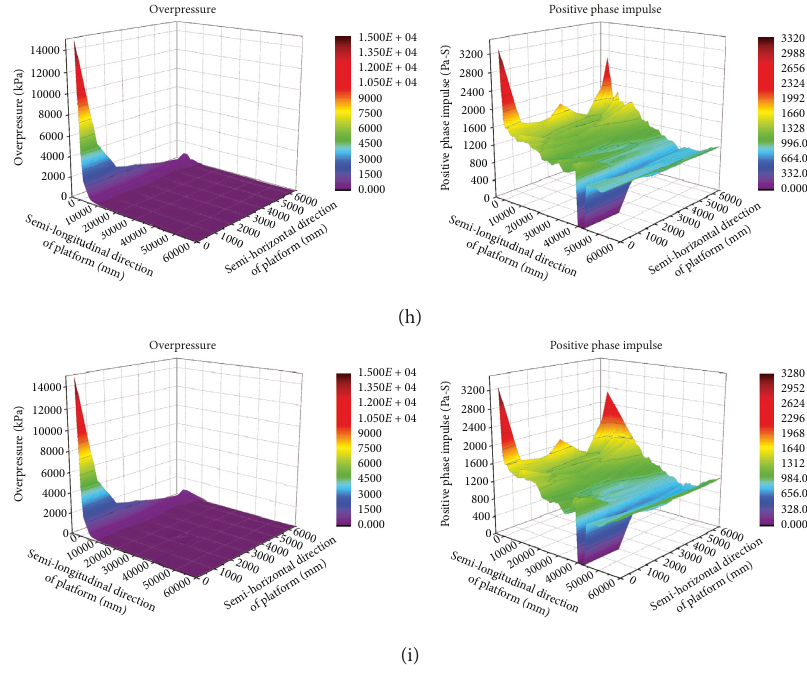
Figure 10: Spatial distribution of shock wave overpressure and positive phase impulse under different conditions. Table 3: Comparative analysis of the strength of shock waves for the explosion on the platform.